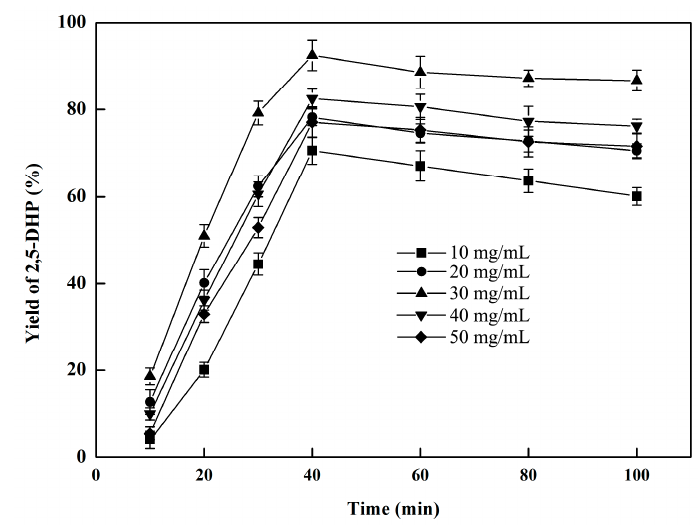
Figure 5. Effect of enzyme concentration of ImmHSPH ZZ on the production of 2,5-DHP.